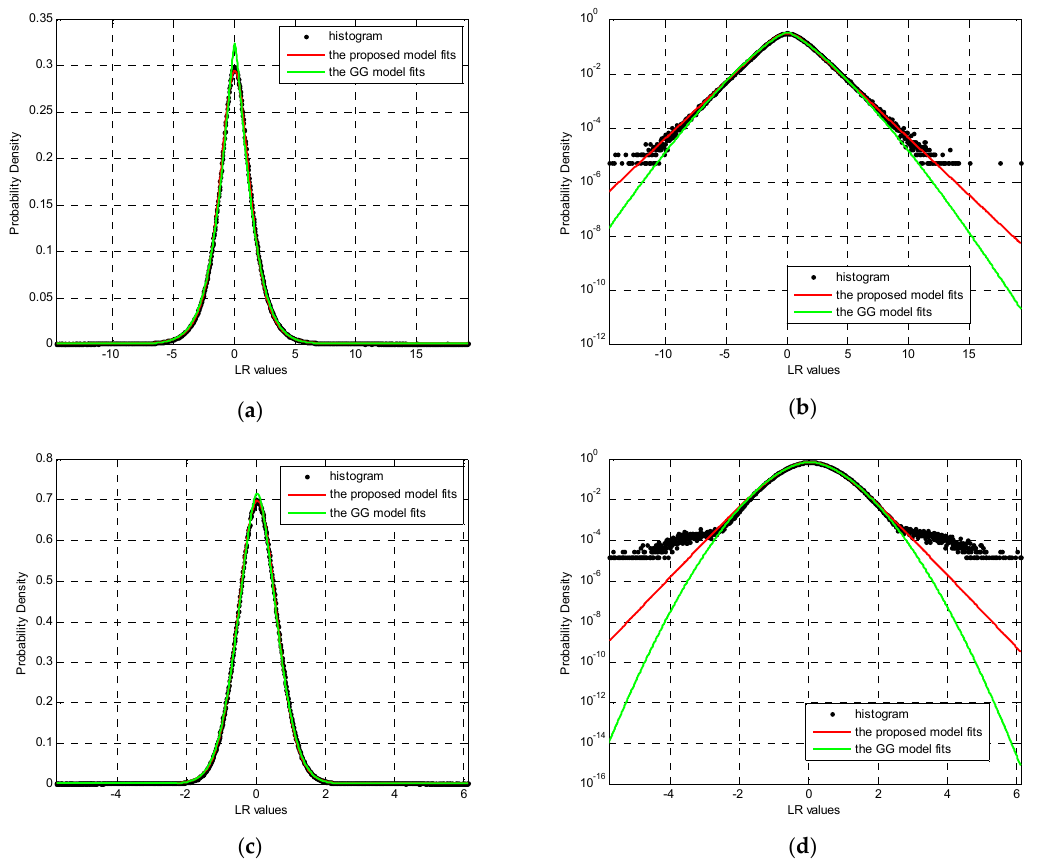
Figure 4. Fitting results of the proposed model for the data shown in Figure 2: ( a ) and ( b ) are the results for a 1 × 1 filtering window displayed on linear and semi-log scales, respectively; ( c ) and ( d ) are the results for a 5 × 5 filtering window displayed on linear and semi-log scales, respectively.